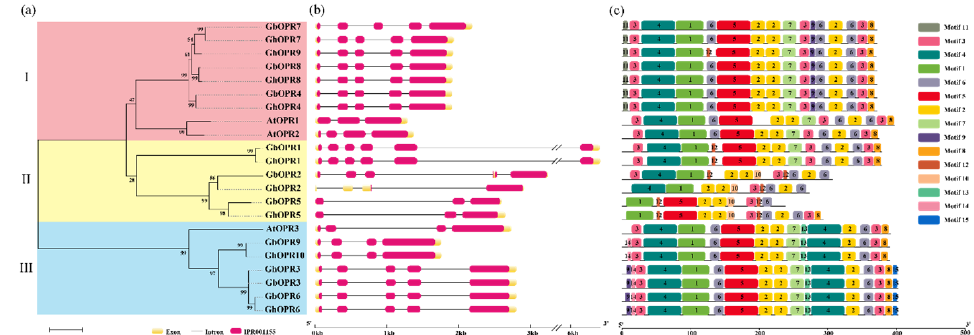
Figure 2. Structural and motif analysis of two allotetraploid cotton OPR genes. ( a ) Phylogenetic tree of OPR genes in G. barbadense and G. hirsutum . The ML phylogenetic tree was constructed by using MEGA X with 1000 replicates. ( b ) Exon-intron structures of GhOPR and GbOPR genes. Orange boxes mean exons, and black lines mean introns, and red color represent conserved domain. ( c ) Conserved motifs of GhOPR and GbOPR proteins. Fifteen conserved motifs are represented by different color boxes.